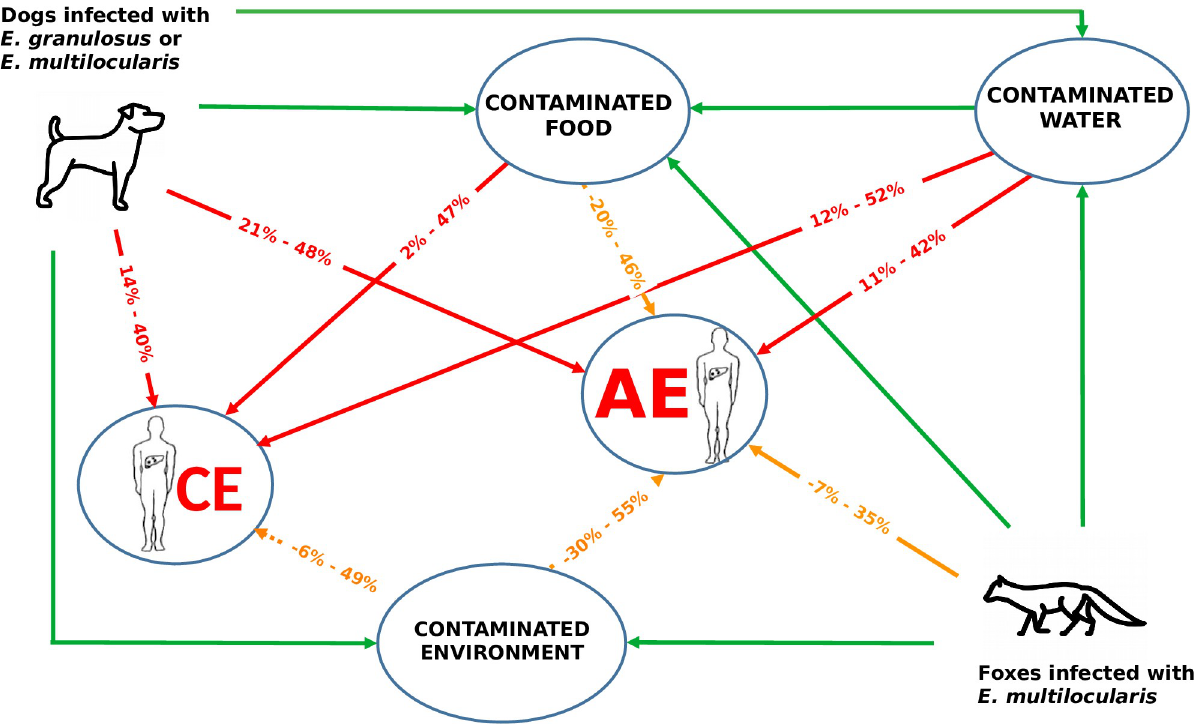
Fig 11. Transmission pathways for E . granulosus and E . multilocularis between the definitive host and humans. The 95% range (CI) for the attributable fraction of each pathway is given. Red lines indicate statistical evidence for the reported AF. Orange lines indicate insufficient statistical evidence (ie CI include 0). Dotted lines indicate the assumed pathway that is the residual AF after others are deducted. Green solid line indicates indirect pathway to human infection.